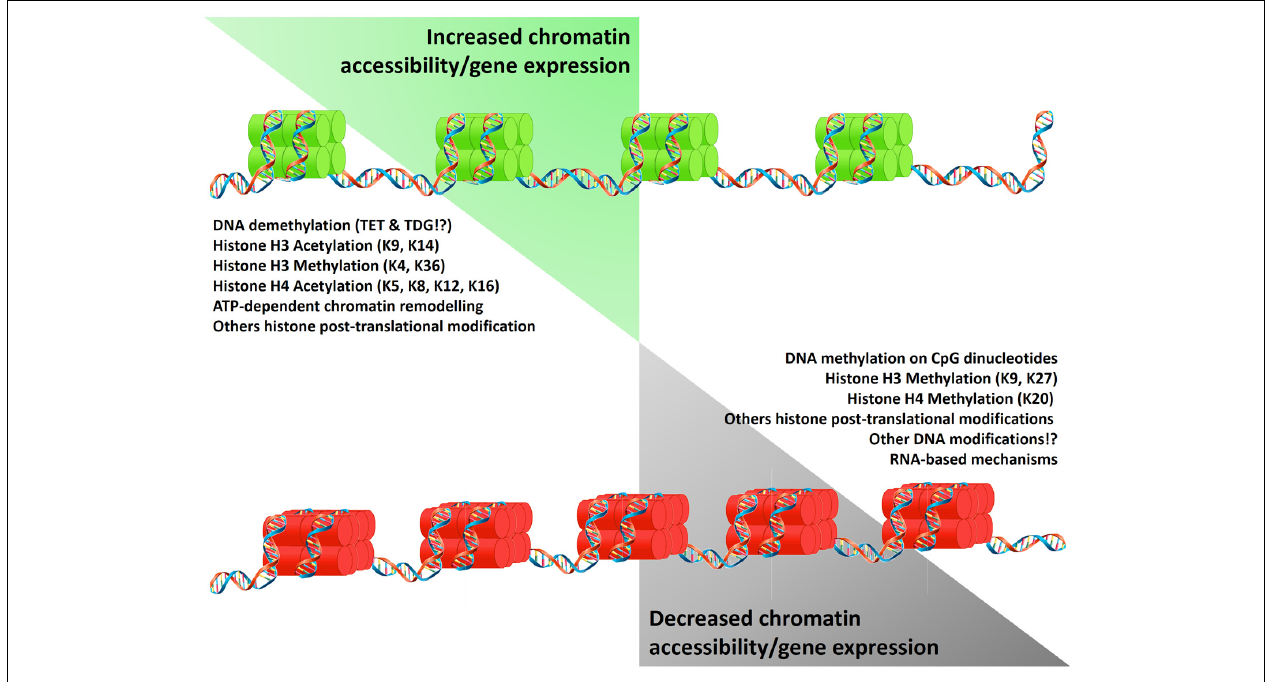
FIGURE 1 | Epigenetic mechanisms regulating gene expression. Epigenetic mechanisms control gene expression by increasing (green histones) or limiting chromatin accessibility (red histones).These states result from the equilibrium of modifications on the DNA and histones which reduce